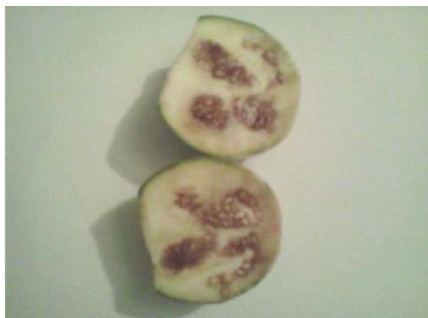
Figure 1: Enzymatic browning in Solanum melongena (elabatu). The black coloration shown is a result due to the production of the pigment melanin which is highly UV